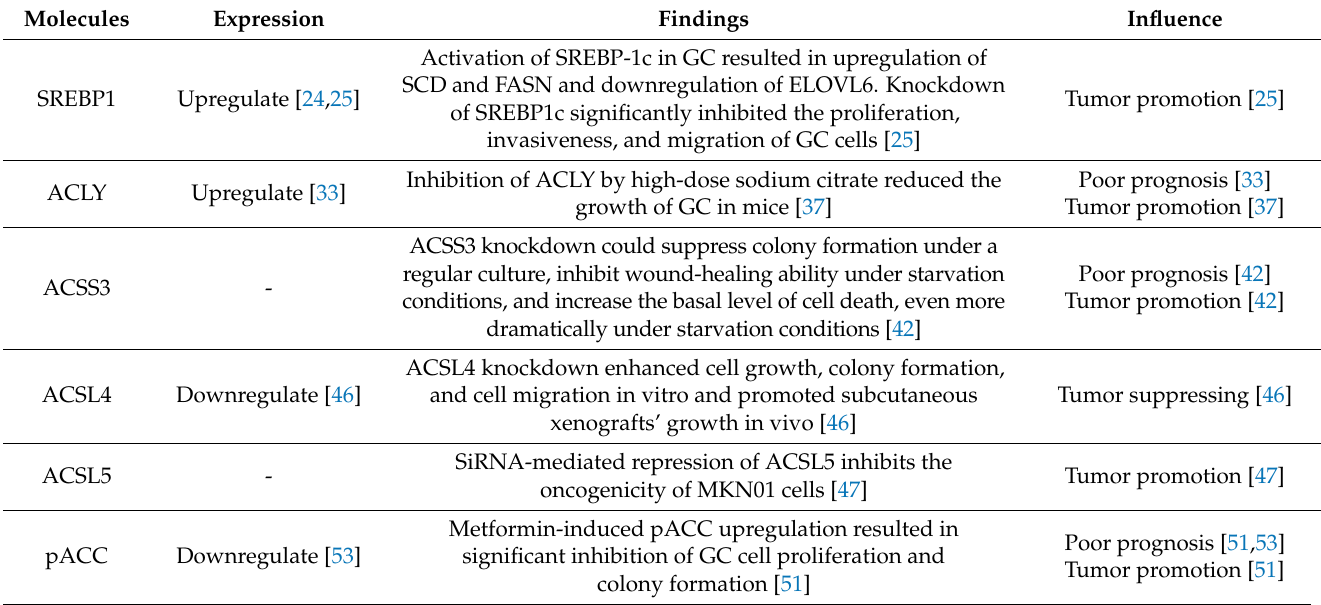
Table 1. Expression of fatty acid metabolism-related molecules and their findings and influences in